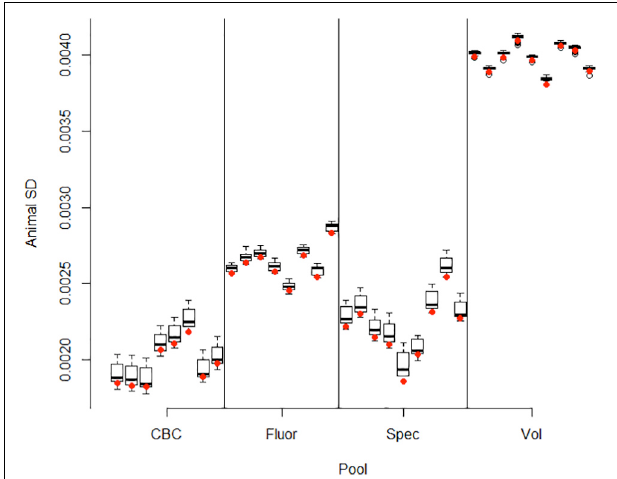
FIGURE 3 | Animal contribution SD by pool. Methods include equal volume of blood diluted to constant white blood cell count (CBC), equal DNA by spectrofluorometry (Fluor), equal DNA by spectrophotometry (Spec), and equal volume of whole blood (Vol). Bivariate ASReml analyses were conducted for all 561 pairs of 34 pools. The variance component for animal contribution was estimated for each pool in combination with all 33 other pools. The restricted maximum likelihood estimate varied slightly by each pairing as evidenced by the interquartile range. The red dot gives the animal SD for the univariate analyses which were used as starting values in the bivariate analyses. In general, information from the paired pool resulting from correlation information had little impact and small interquartile difference and ranges in estimates for a given